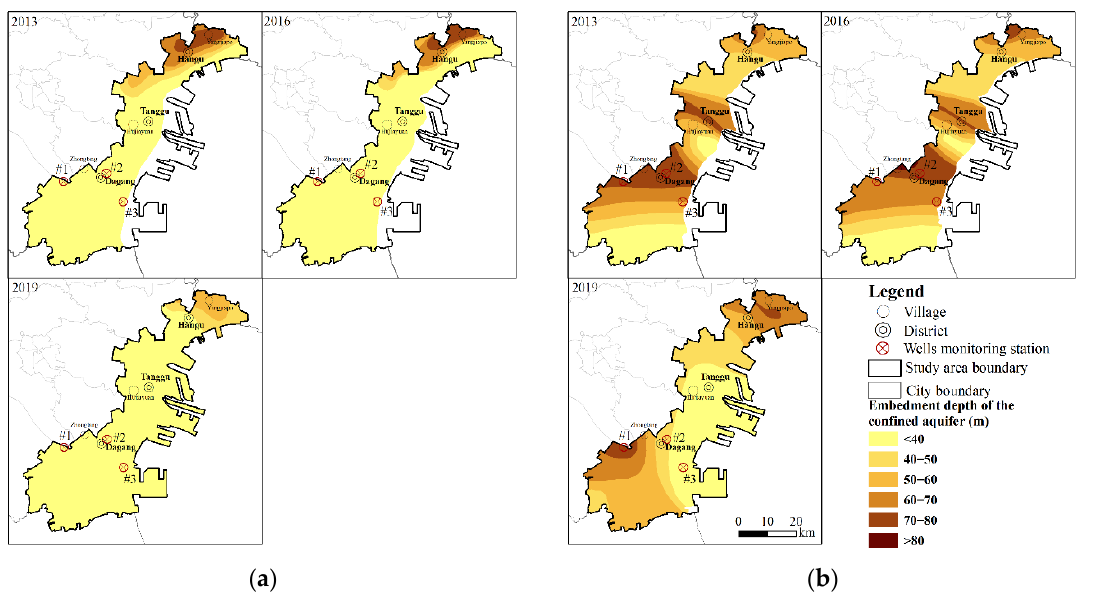
Figure 9. The contour lines of groundwater level depth of the second ( a ) and third ( b ) confined aquifer group in 2013, 2016, and 2019.